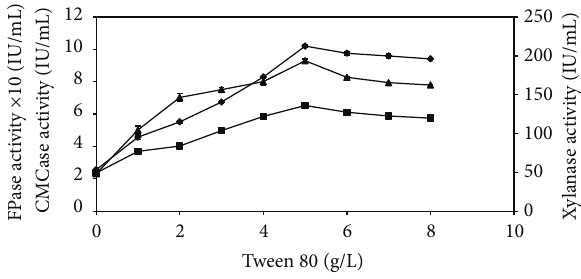
Figure 8: Effect of Tween 80 on CMCase, FPase, and xylanase activities. Results are presented as the mean of three replicates with standard deviation: ( Q ) FPase; ( ◼ ) CMCase; ( 󳵳 ) xylanase.